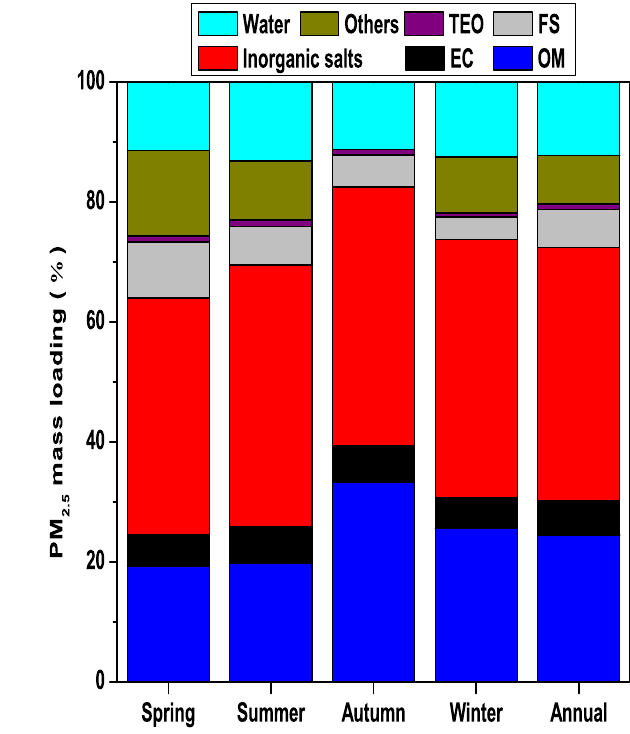
Figure 5. Chemical mass closures of PM 2 . 5 mass